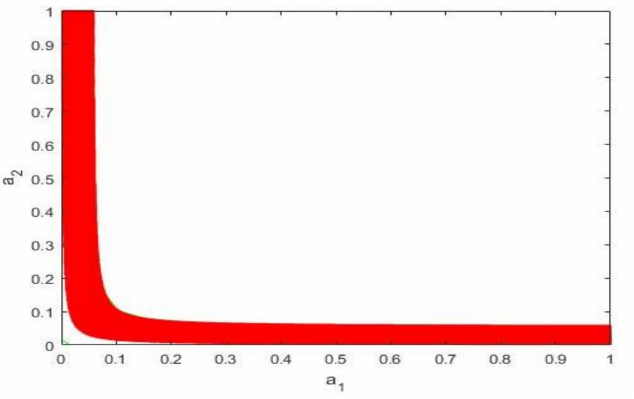
Figure 4. The stable region of the Nash equilibrium point in-plane ( α 1 , α 2 ) , α 3 =